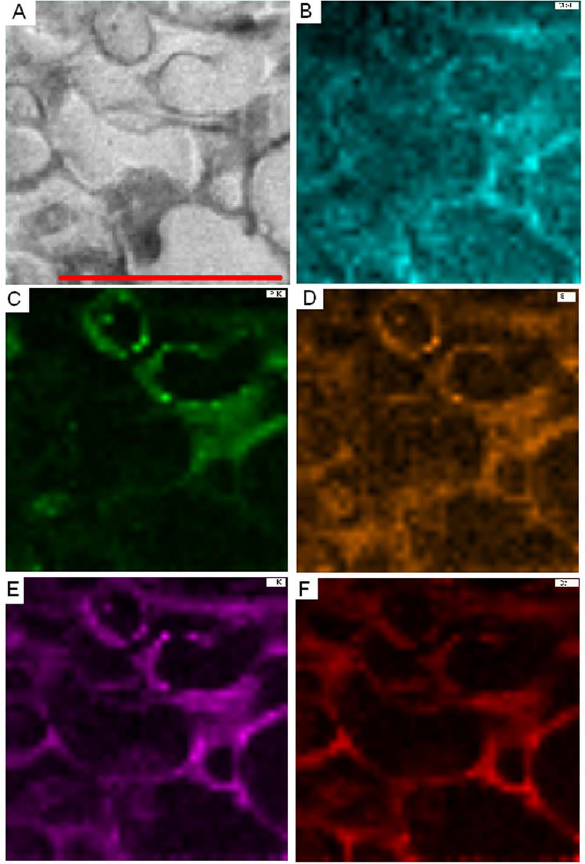
Fig. 2. EDX-STEM-mapping of an ectomycorrhizal root of beech ( Fagus sylvatica ) colonized by Lactarius subdulcis . EDX-STEM-mapping of 40 6 40 measurement points in the area depicted (A) of magnesium (B, turquoise), phosphorus (C, green), sulphur (D, orange), potassium (E, purple), and calcium (F, red). Scale bar: 10 m